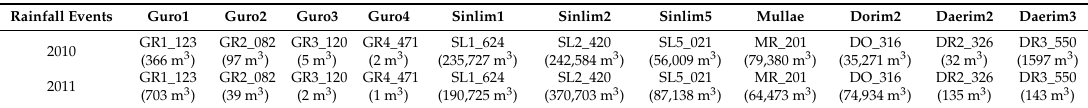
Table 7. The results of maximum flooding nodes for the operation of drainage facilities in each drainage